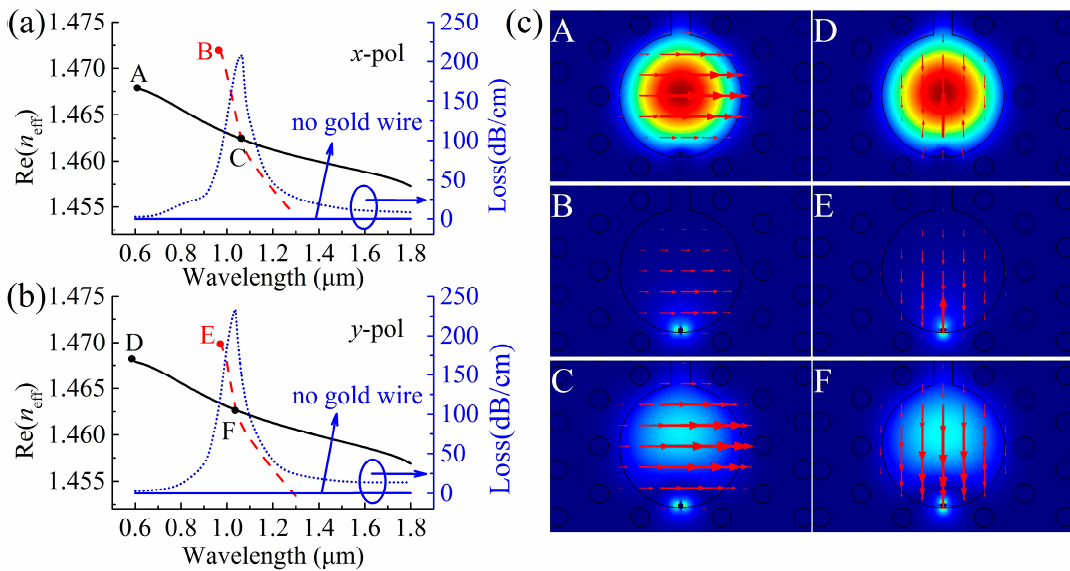
Figure 2. ( a ) Dispersion relations of the x -polarized core mode and surface plasmon polaritons (SPP) mode, losses as a function of wavelength for the x -polarized core mode, ( b ) dispersion relations of the y -polarized core mode and SPP mode, losses as a function of wavelength for the y -polarized core mode when the n is 1.47, and ( c ) electric field distributions of the relevant modes where the red arrows show the polarization direction of the electric field.